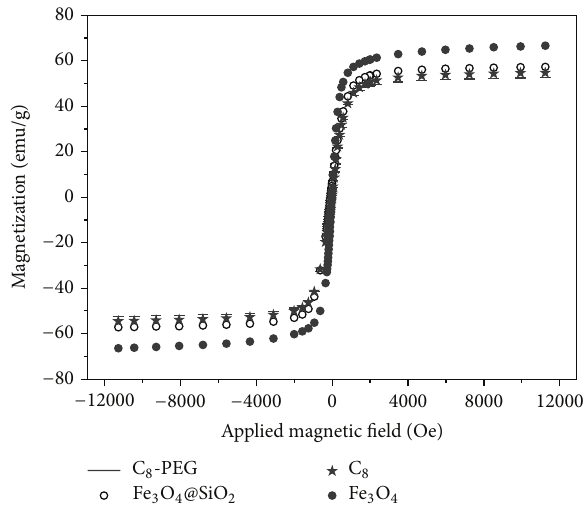
Figure 4: VSM magnetization curves of Fe 3 O 4 , Fe 3 O 4 @SiO 2 , C 8 , and C 8 -PEG.